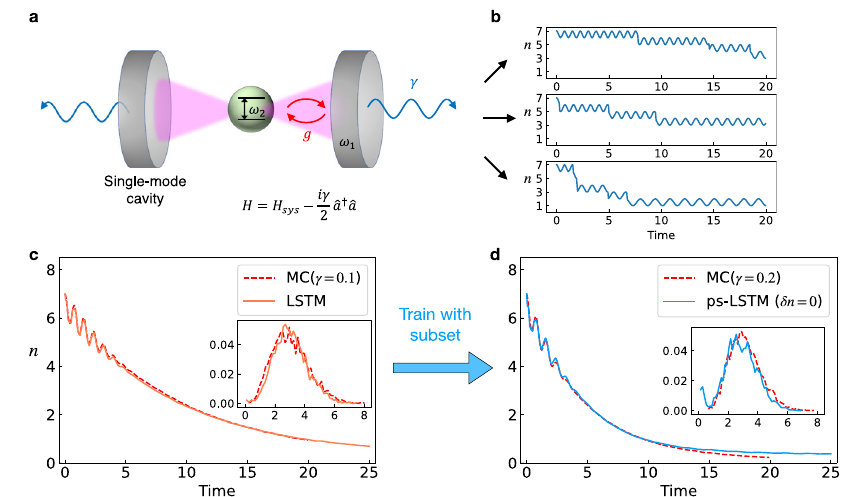
Fig. 5| Quantum jump trajectoriesgenerated fromps-LSTM. a Schematicof the averaging over 2000 MC simulations with γ =0.1 (dashed red line) and 2000 pre- open quantum system we simulate. The system consists of a two-level atom sur- dictions generated by LSTM (solid orange line). The inserted panel shows the dis- (cid:5) rounded by the cavity, where the initial state is chosen to be ∣ 7 i (cid:6) ∣ " . The cavity tribution of the variance calculated over each trajectory, where the x-axis is the photons not only experience interaction with the atom but also interact with the varianceandthey-axisisthecorrespondingprobability. d Theexpectationvalueof environmentviacontinuouslydissipatingphotonstotheenvironment.Thesystem number of photons 〈 n 〉 asa function of time obtained by averaging over 2000 MC can be described by the Hamiltonian written below the plot, where system simulations with γ =0.2 (dashed red line) and 2000 predictions generated by ps- Hamiltonian H sys isjustEq.(12)with ω 1 = ω 2 =2 π . b Somerepresentativetrajectories LSTM (solid blue line). The inserted panel shows the distribution of the variance calculated over each from the quantum jump simulations which we use to train LSTM and ps-LSTM. c Theexpectationvalueofnumberofphotons 〈 n 〉 asafunctionoftimeobtainedby